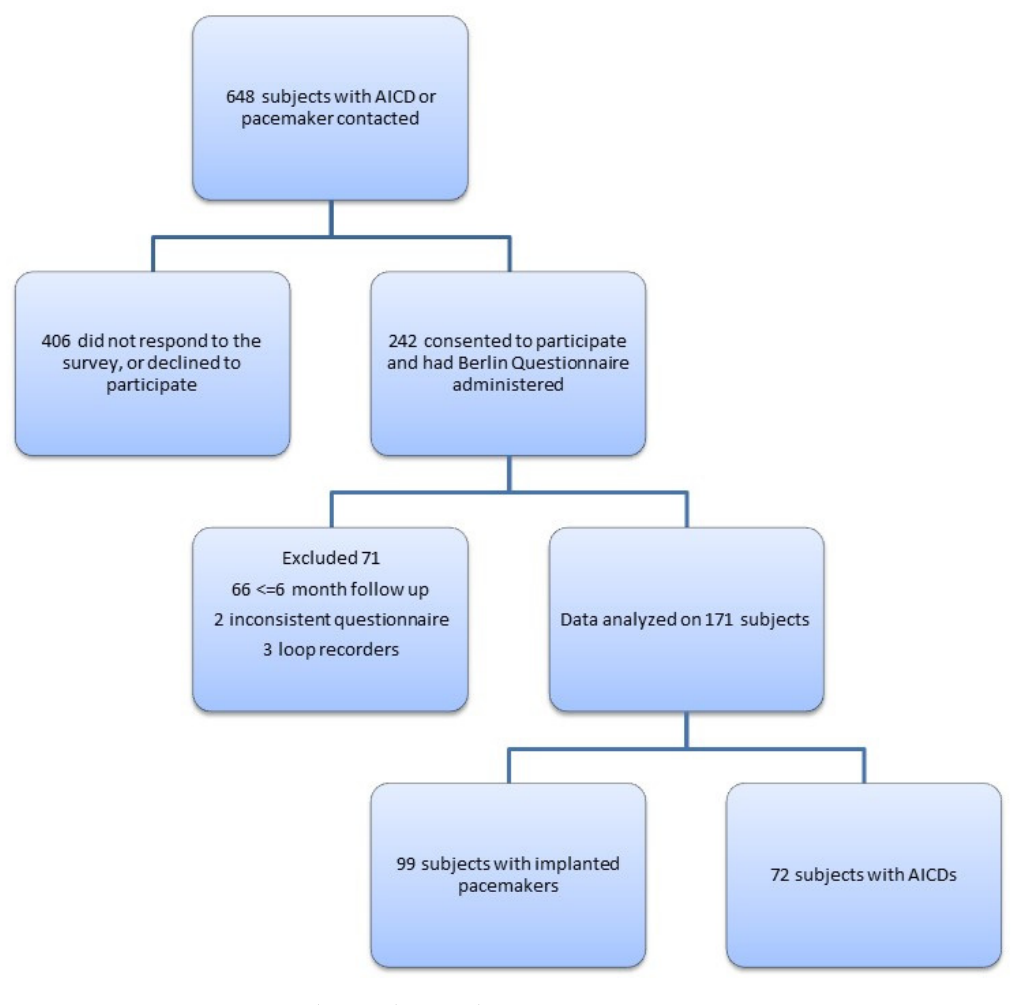
Figure 1. Study population selection.